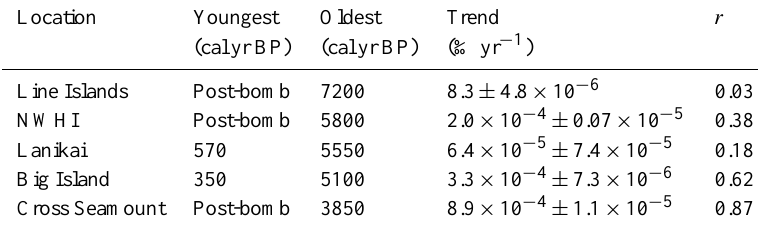
Table 1. Trends in late Holocene Gerardia δ 15 N values as a function of